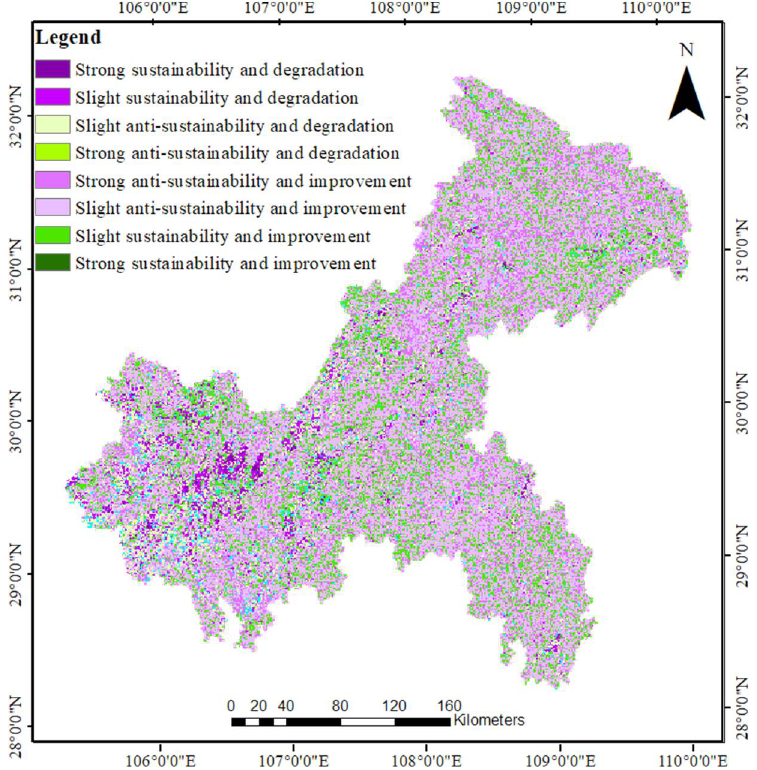
Figure 14. Future vegetation-cover change trends predicted based on the Hurst index.